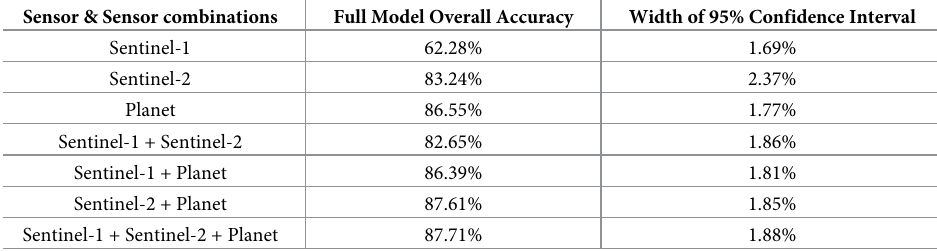
Table 4. Classification results and 95% confidence intervals for single and multiple sensor models for the full study period